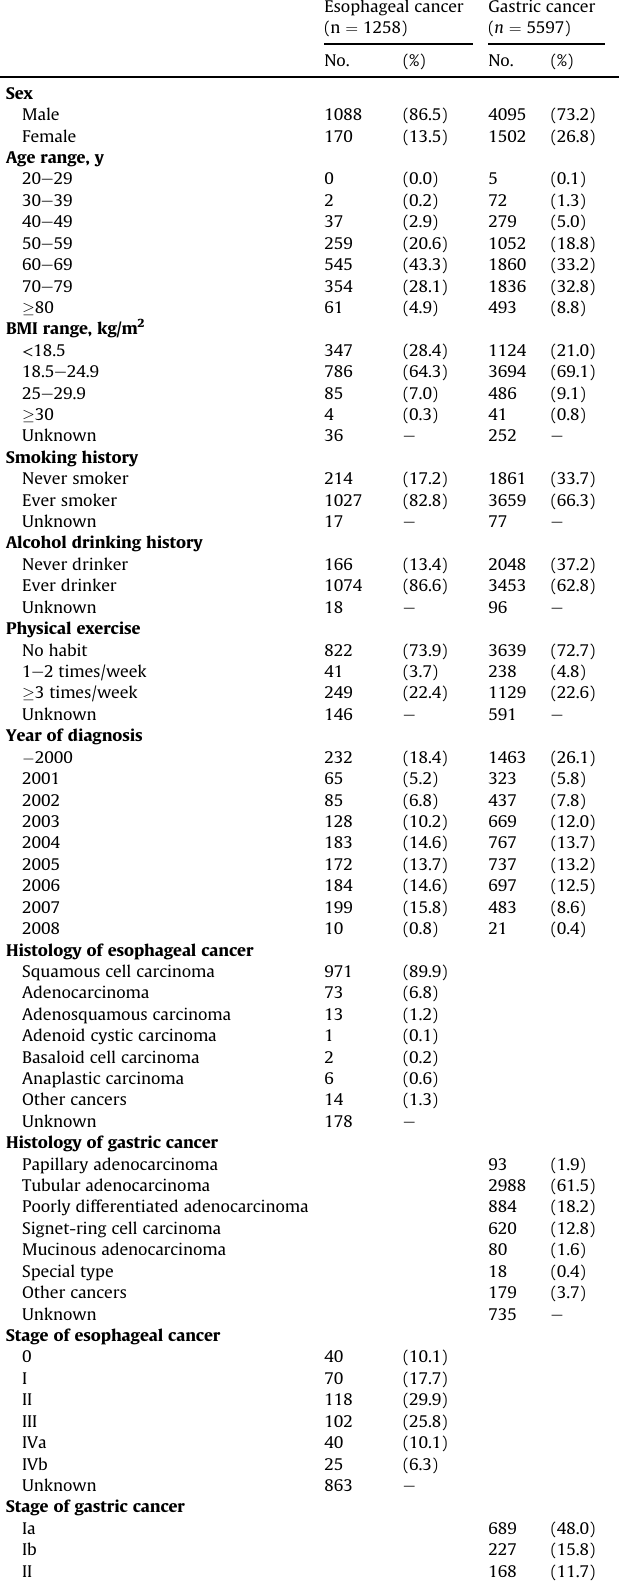
Table 1 Demographic and lifestyle factors of patients with esophageal and gastric cancer at baseline in the Biobank Japan